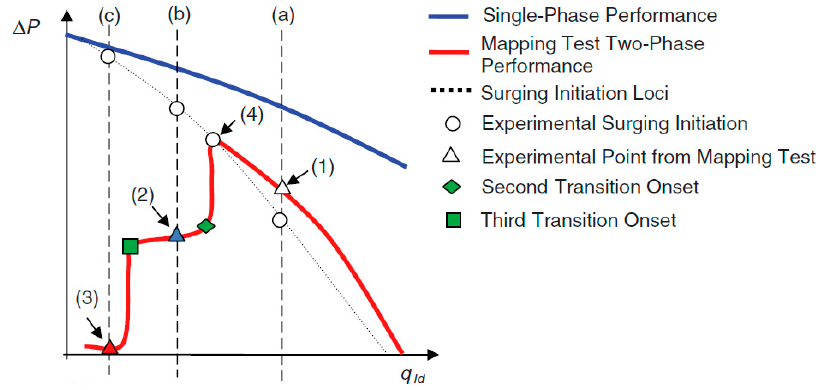
Figure 16. Flow pattern recognition by interpreting performance curves [72].